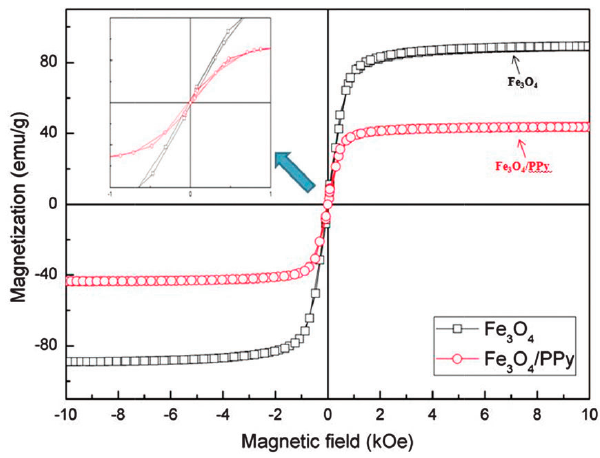
Figure 14. Magnetization curves of Fe 3 O 4 and Fe 3 O 4 /PPy (Park et al. [97], © The Royal Society of Chemistry, 2015).